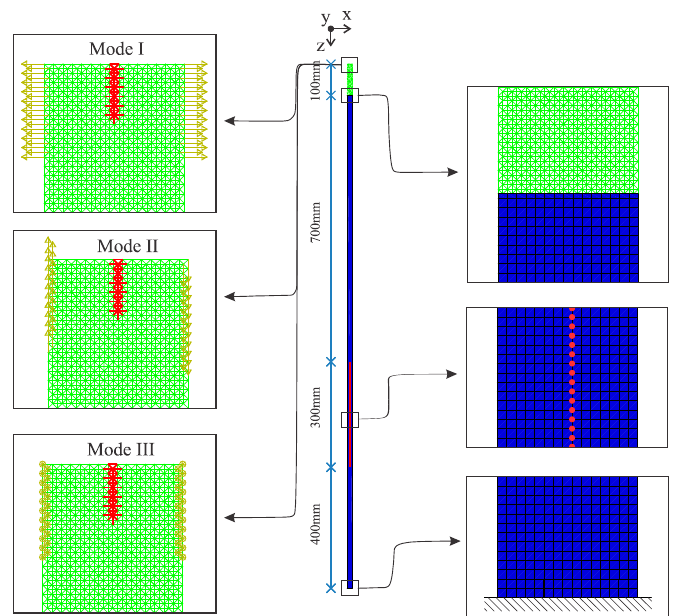
Figure 19. The pre-fissured prismatic metallic waveguide modeled with LDEM + FEM. The boundary conditions are also depicted.